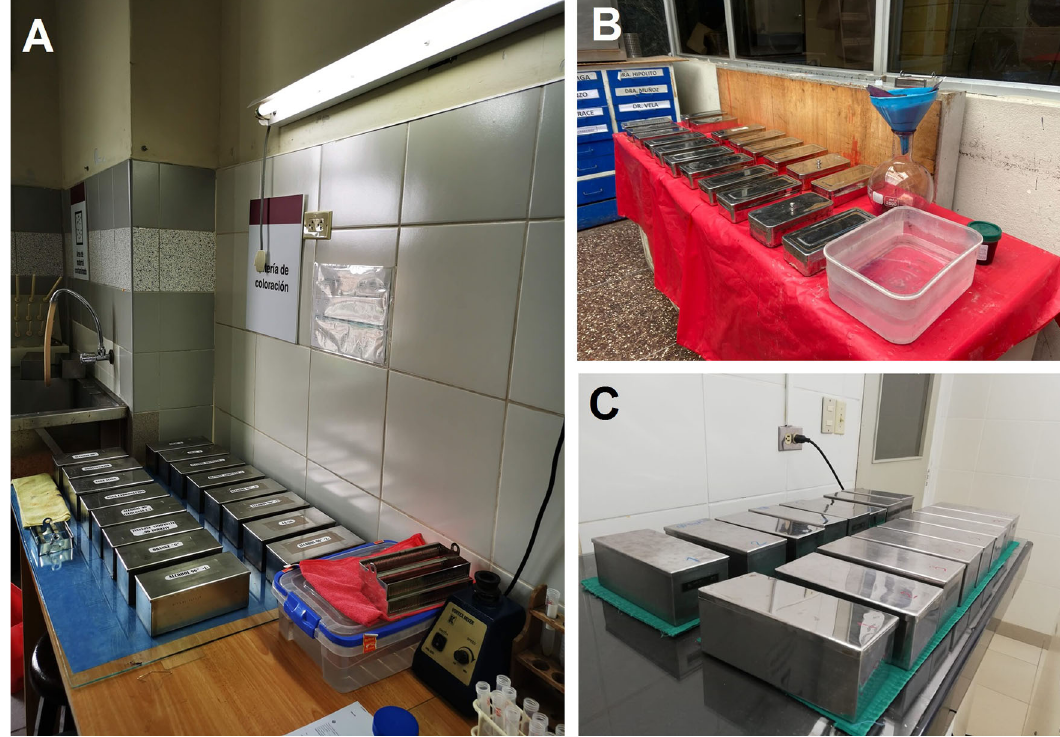
Figure 2. Biosafety conditions in cytology laboratories. (A) Guillermo Almenara Irigoyen National Hospital, (B)HospitalNacionaldeEmergenciasGrau,(C)EdgardoRebagliatiMartinsNationalHospital.Notethatallstainingcenters are manual and are exempt from basic protection barriers such as the laminar flow chamber and air filtration systems.